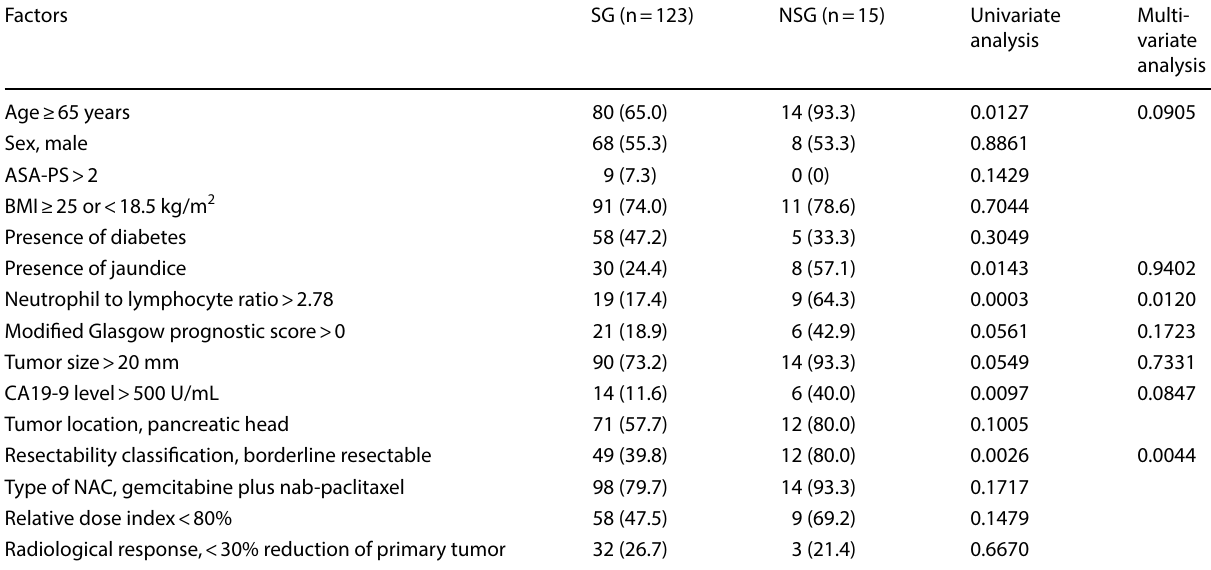
Table 3 Univariate and multivariate analyses of predictive factors associated with operability after neoadjuvant chemotherapy